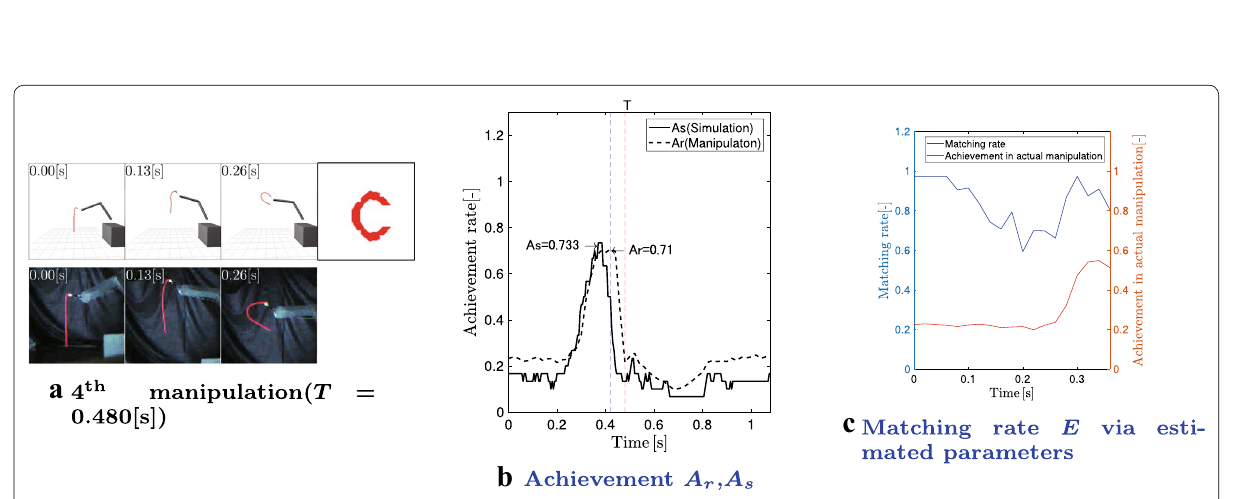
Fig. 15 Manipulation result of desired image of string shape: